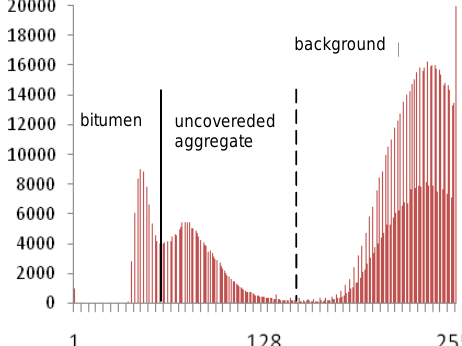
Figure 9: Histogram of minstore-image.